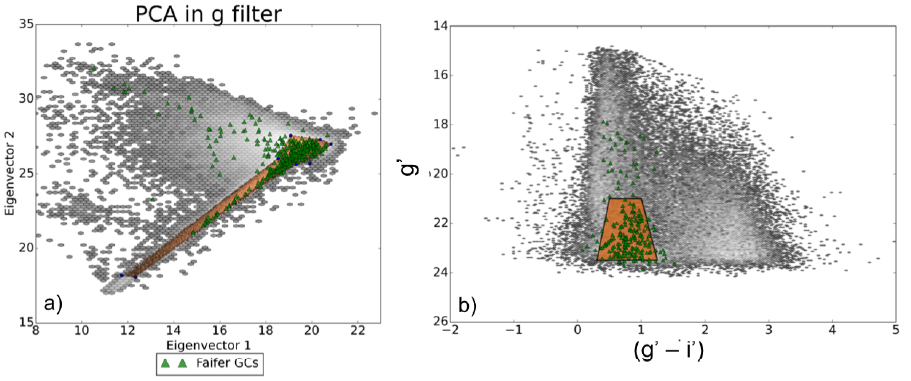
Figure 3. ( a ) Star + globular cluster (GC)/galaxy separation using principal component analysis (PCA). Most of the power is in the FLUX_RADIUS and SPREAD_MODEL parameters. Green triangles represent GCs and ultra-compact dwarfs (UCDs) from [13]. ( b ) Globular cluster candidates were then selected to be in the orange polygon in the color-magnitude diagram